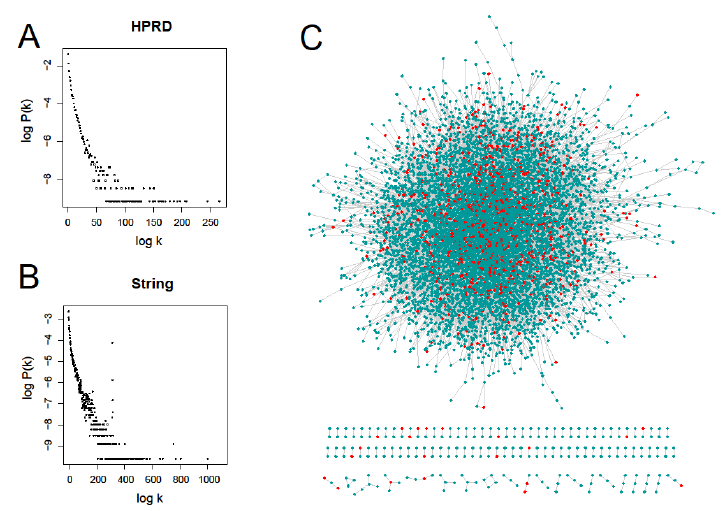
Figure 2. Human protein-protein interaction networks and their node degree distributions. ( A ) and ( B ) represent their power-law degree distributions of the Human Protein Reference Database (HPRD) network and the String network respectively; ( C ) the HPRD network consisting of 9402 notes and 36,746 edges (V9.0) and the scattered red nodes represent prognostic genes.